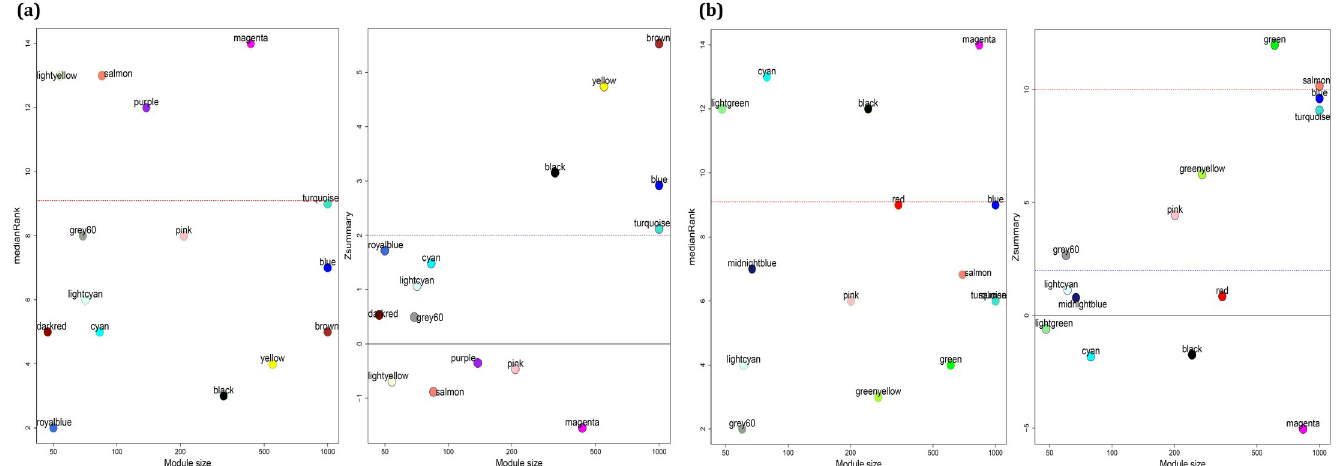
Fig 3. The medianRank and Z summary preservations plots against module size for determining preserved modules of (a) HAM/TSP and (b) ATLL modules in the external dataset. Modules with a medianRank � 9 and Z summary > 2 were considered as moderate-high preserved modules.